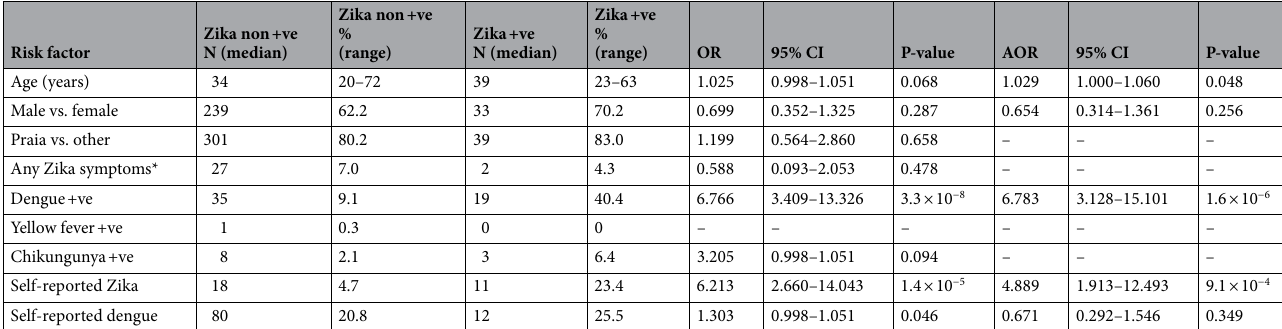
Table 2. Odds ratios (ORs) for risk factors for Zika positivity (n = 47) versus non-positivity (n = 384). AOR adjusted odds ratios estimated by a multivariate model that includes all listed risk factors, CI confidence intervals; *a rash, myalgia, nausea, or